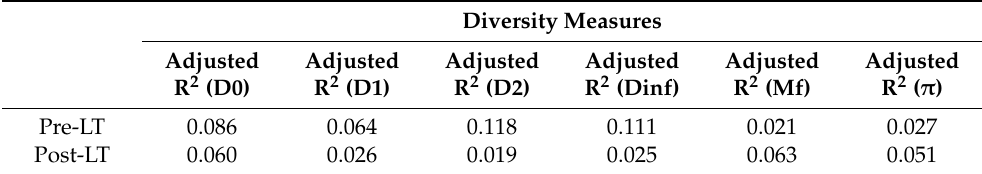
Table 1. Ability of diversity measures (qD of order 0, 1, 2, infinity, Mfmax, and π ) to predict high or low fibrosis degree at 1 year post-LT using both pre-LT and 15 day post-LT samples. Prediction accuracy of each diversity measure is represented as adjusted R2.